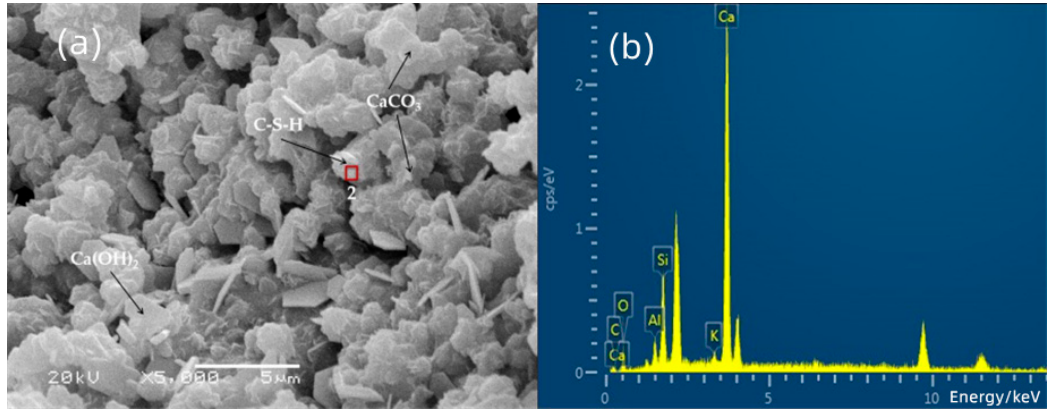
Figure 8. The micromorphology and EDS results of the hydraulic lime K3 fractured samples at 7 days: ( a ) SEM image of K3 mortar curing 7 days; ( b ) EDS result.